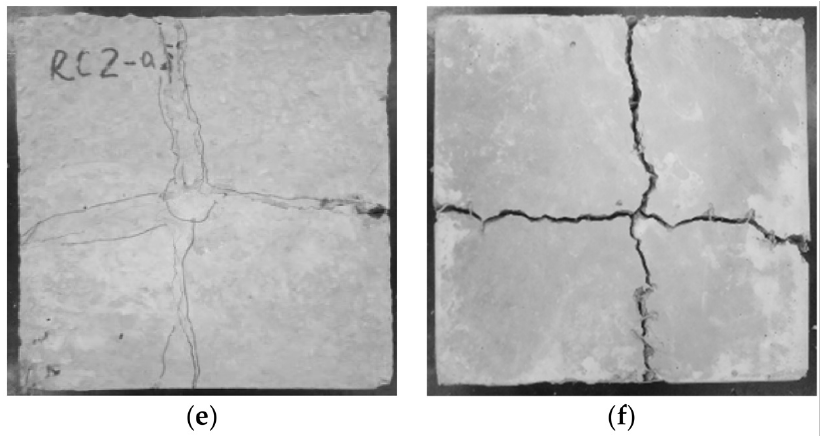
Figure 10. Comparison of impact failure modes of specimens: ( a ) R50-H0 (front); ( b ) R50-H0 (back); ( c ) R100-H0.5 (front); ( d ) R100-H0.5 (back); ( e ) R100-C0.5 (front); ( f ) R100-C0.5